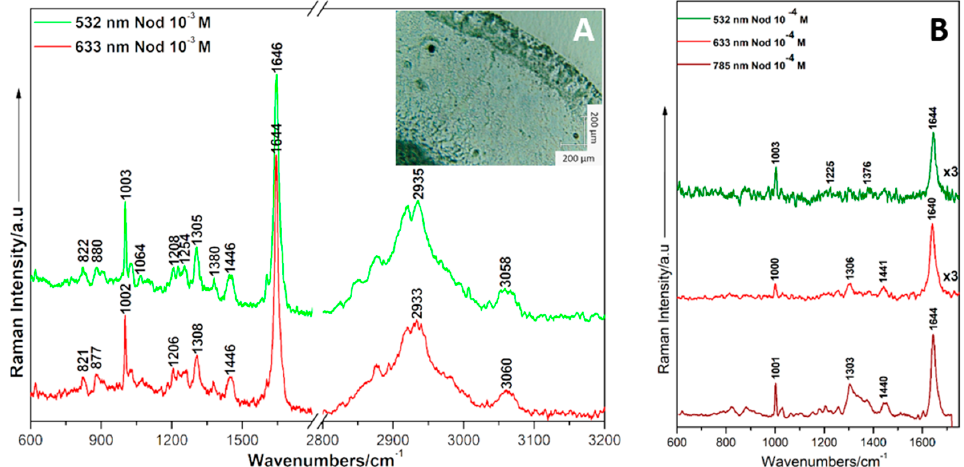
Figure 3. DCDR spectra recorded on Tienta ® SpectRIM TM substrate for NOD in ethanol with a final concentration of 10 − 3 M ( A ) and 10 − 4 M ( B ), respectively by using the 785 nm, 532 nm and 633 nm laser lines. Inset with optical image by using 20× objective.